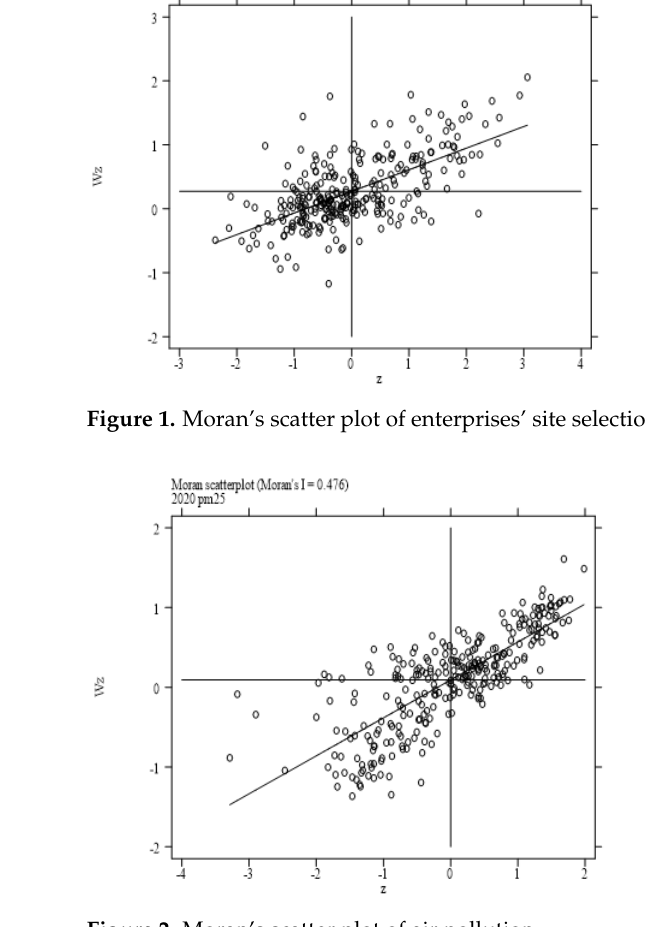
Figure 3. Enterprises Distribution. Note: The arithmetic mean values of the enterprises ’ site selection (2014 – 2020) is adopted.